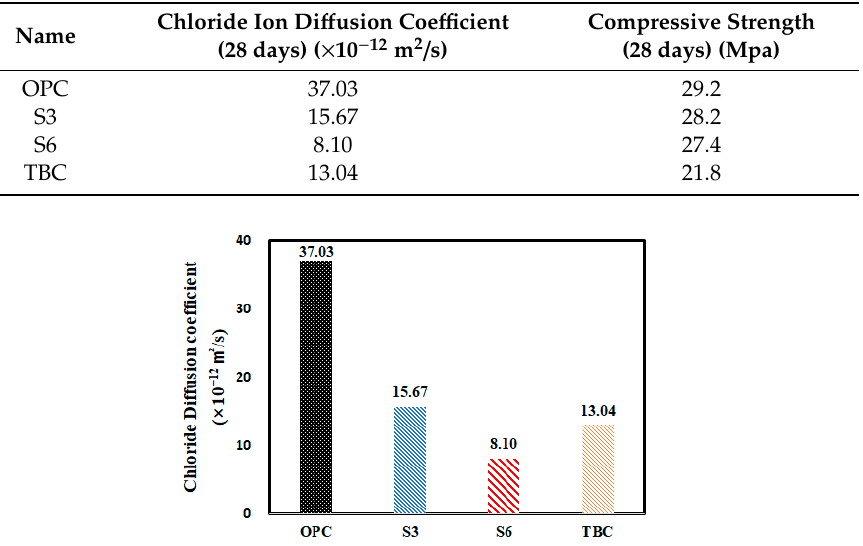
Figure 9. Chloride ion diffusion coefficient of concrete according to binder type.